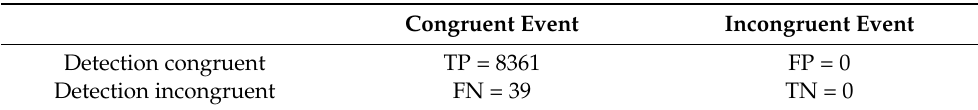
Table 8. Contingency table that assists with the detection of congruences in the Landsat 8 scene of the Doce River basin acquired in 2016 and consisting of 8400 tiles (TP—true positive, FP—false positive, FN—false negative, TN—true negative).